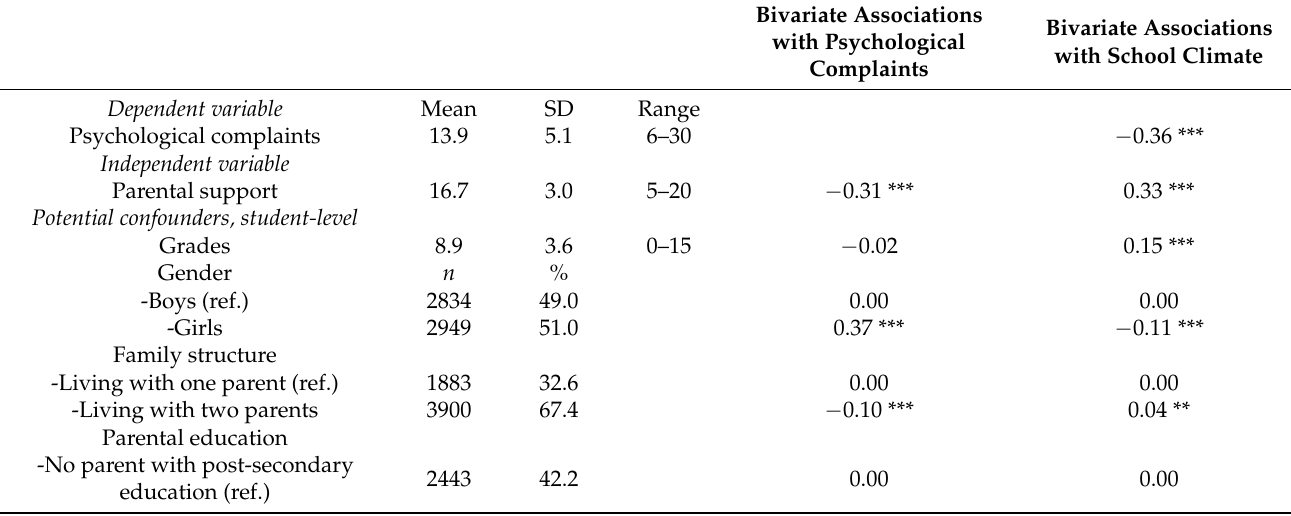
Table 2. Descriptive statistics and bivariate associations of all variables included in the analyses. n = 5783 students across 152 school